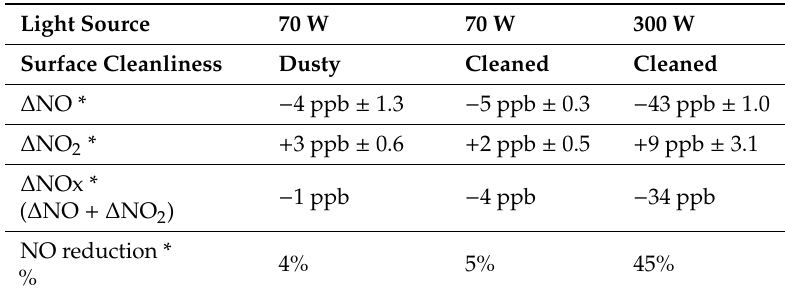
Figure 6. Concentration of NO x over time (cleaned samples, 70 W light source). Table 1. Air purification performance test